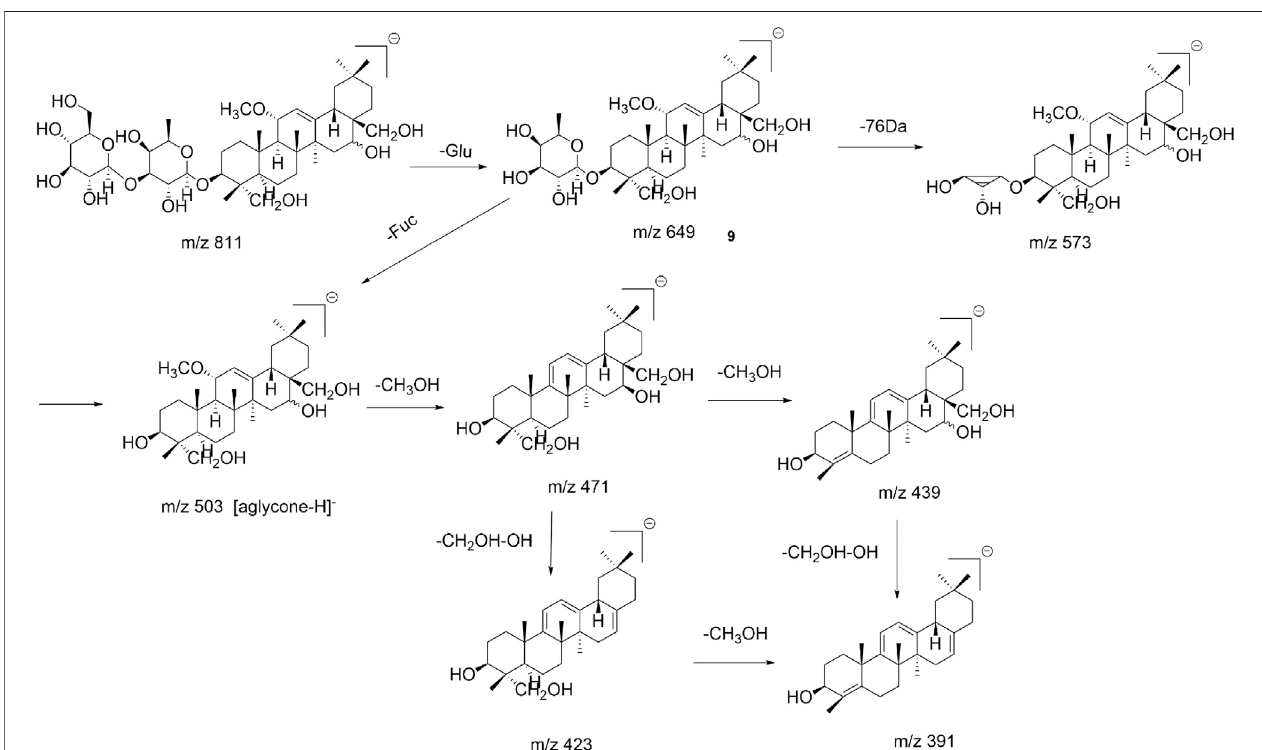
FIGURE 4 | Fragmentation pathway of SSb 3 /SSb 4